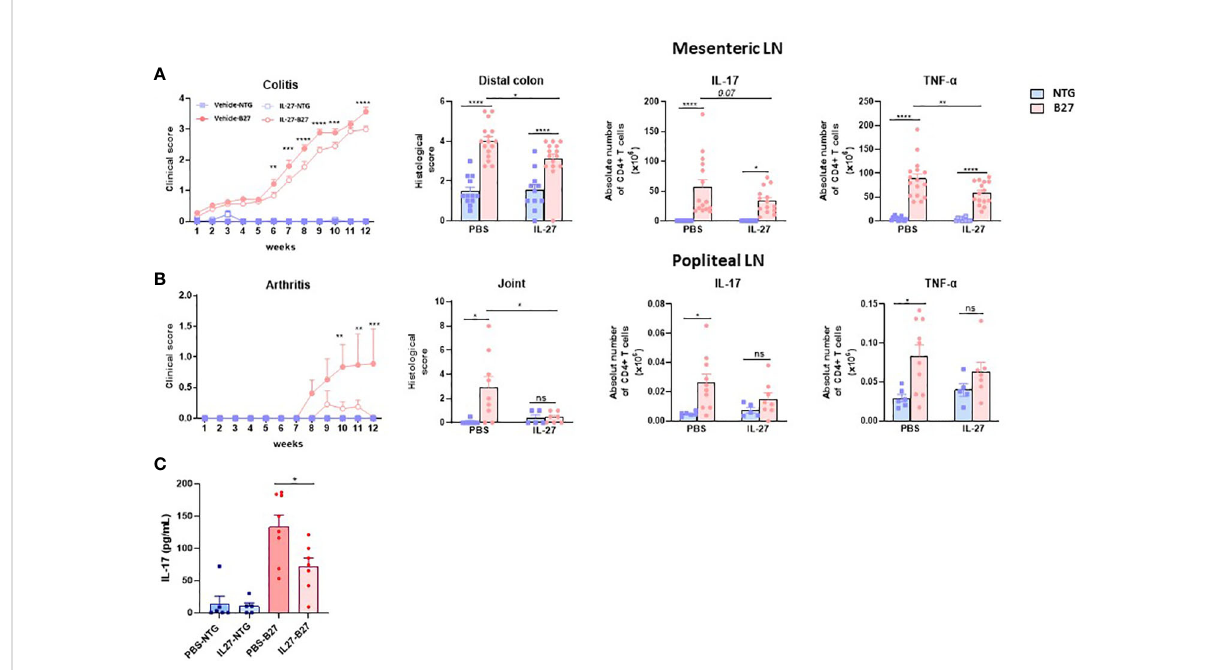
FIGURE 6 RrIL-27 reduces SpA severity in B27-rat. (A) Clinical score of colitis (experiment 2), histological score of distal colon in fl ammation and absolute number of cytokines producing T cells (pooled experiments 1 and 2) were determined in mesenteric LN from NTG and B27-rats aged of 4-6 weeks treated with vehicle or rrIL-27 for 12 weeks. (B) Clinical score of arthritis, histological score of hindpaws and the absolute number of cytokines producing T cells in popliteal LN were determined in NTG and B27-rats treated with vehicle or rrIL-27 for 12 weeks (experiment 2). (C) IL-17 levels in serum from NTG and B27 treated with PBS or IL-27. Values are the mean ± SEM of 6-8 rats/group. *p < 0.05 ***p<0.0005 ****p<0.0001. **p=0.002. ns, not signi fi